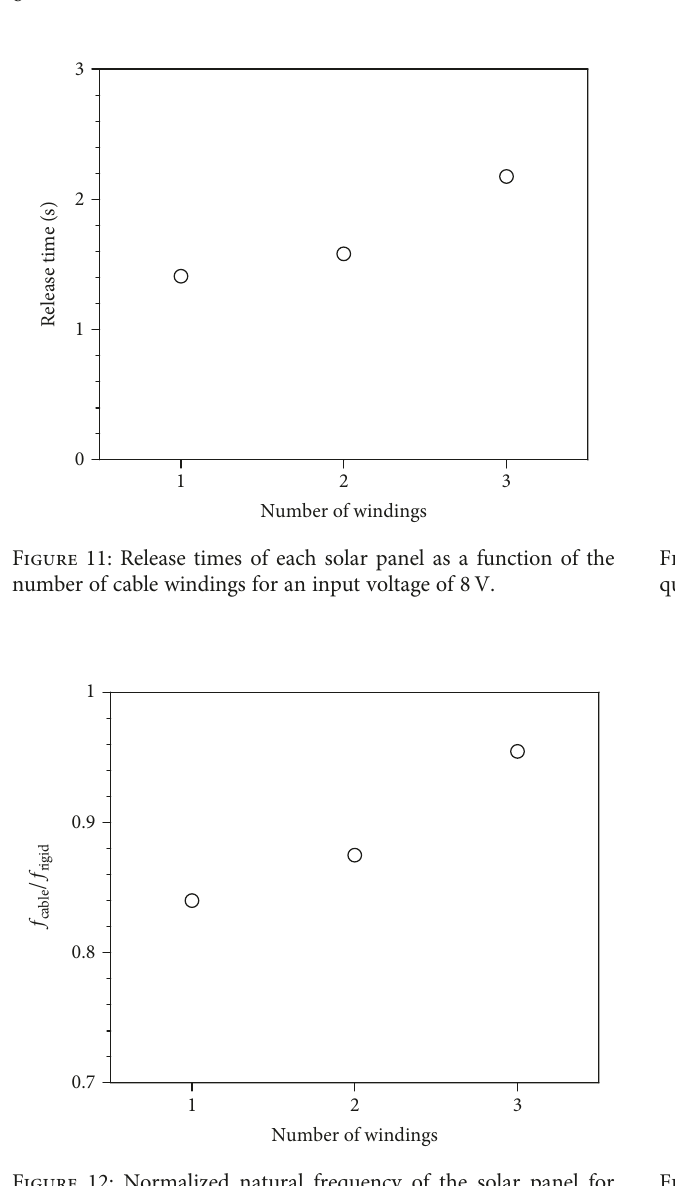
Figure 14: Normalized natural frequency of the solar panel as a function of quali fi cation temperature